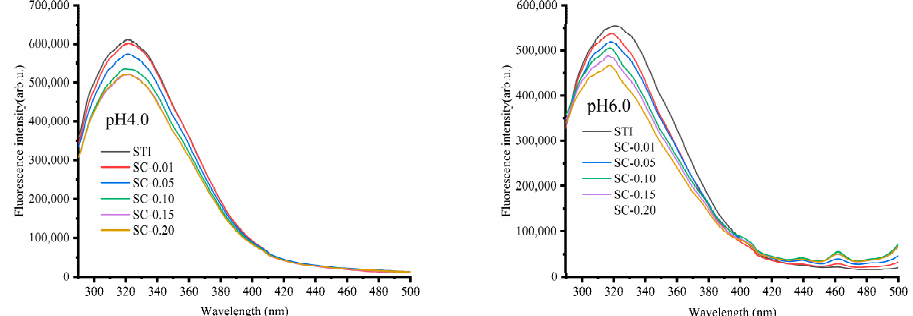
Figure 4. The effect of CS concentration on the fluorescence intensity of STI at pH 4.0 and Figure (cid:561) 4. (cid:561) The (cid:561) e (cid:283) ect (cid:561) of (cid:561) CS (cid:561) concentration (cid:561) on (cid:561) the (cid:561)(cid:282) uorescence (cid:561) intensity (cid:561) of (cid:561) STI (cid:561) at (cid:561) pH (cid:561) 4.0 (cid:561) and (cid:561) 6.0. (cid:561) 3.5. (cid:561) Circular (cid:561) Dichroism (cid:561) Spectroscopy (cid:561)